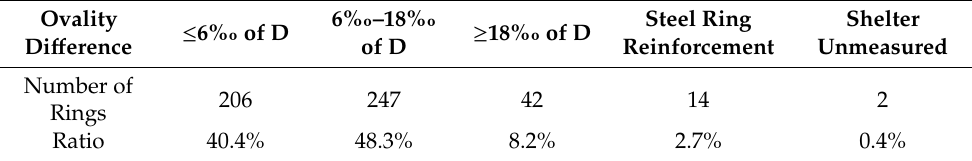
Table 4. Statistical table of ovality .